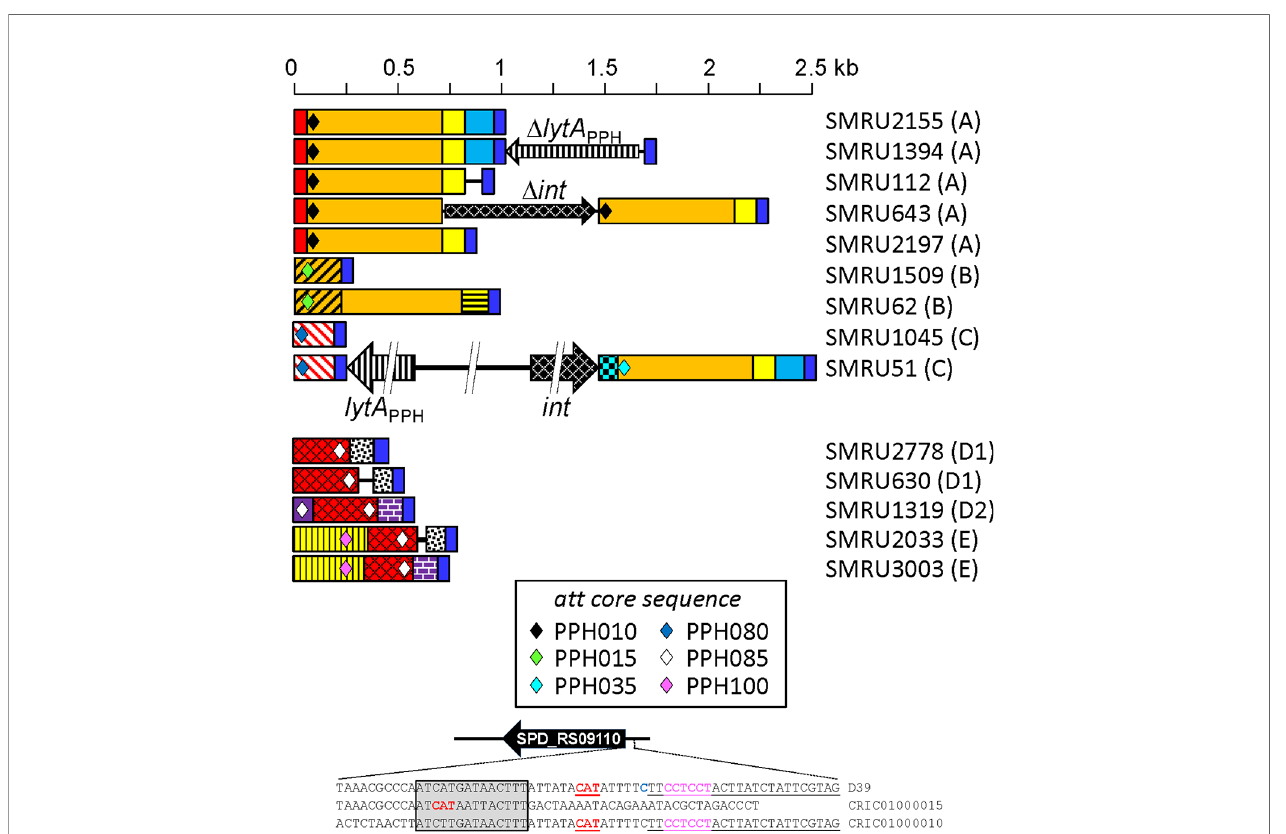
FIGURE 6 | Diagram of the region located immediately downstream of the termination codon of lytA Spn * in 14 pneumococcal strains with differently rearranged genomes. The region corresponds to that indicated with a gray square in Figure 4 . DNA regions sharing ≥ 95% nucleotide identity are shown with the same color and shadowing. The type of arrangement (A to E) is indicated in parentheses to the right of the name of each strain. The different core attachment sites are shown as diamonds. The deep blue rectangles represent the conserved 51 bp-long sequence mentioned in the text. The red rectangles correspond to the reverse complement of positions 24037 – 24121 of the S. pneumoniae D39 genome (between SPD_RS00120 encoding a nucleoside deaminase and SPD_RS00115 coding for an adenylosuccinate synthase). The purple rectangle corresponds to positions 1,712,485 – 1,712,386 (between SPD_RS09110 and SPD_RS09115 in the D39 chromosome). For additional information see Tables S6 and S8 . At the bottom, the nucleotide sequence surrounding the initiation codon of SPD_RS09110 in strains D39 and SMRU1319 (arrangement D2) is shown. The correct initiation codon is shown in red, bold font, and underlined. Another in-frame initiation codon is not underlined and apparently lacks a potential ribosome-binding site (RBS) (Acc. No. CRIC01000015). The predicted RBS of SPD_RS09110 is shown in pink lettering. The 14 bp-long repeat potentially responsible for a chromosomal inversion in strain SMRU1319 is inserted in a gray box. The att core sequence of PPH085 is